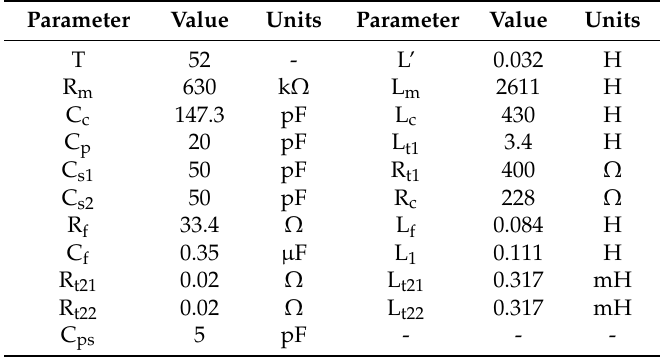
Table 2. Values of the lumped elements of the “TRIAL#1” equivalent circuit. Parameter